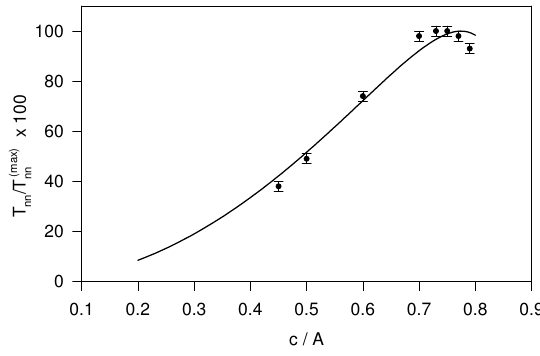
Figure 2: Comparison of theoretical (Eq. 15) and measured results [20] for the ratio T nn /T (max) nn versus the dimension- less radial distance c/A of the pole center.